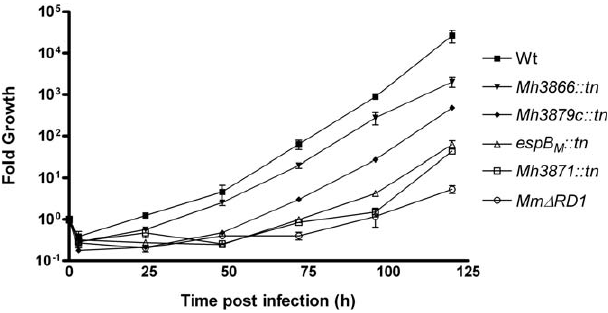
Figure 3. Growth of M. marinum Secretion Mutants in BMDMs BMDMs were infected with M. marinum strains as described in Materials and Methods at a multiplicity of infection of 1, and growth of bacteria was monitored over time as in Figure 1. Data are summarized from three independent experiments. Strains differed significantly by one-way ANOVA after 24 h, 48 h, 72 h, 96 h, and 120 h ( p , 0.001 for each).